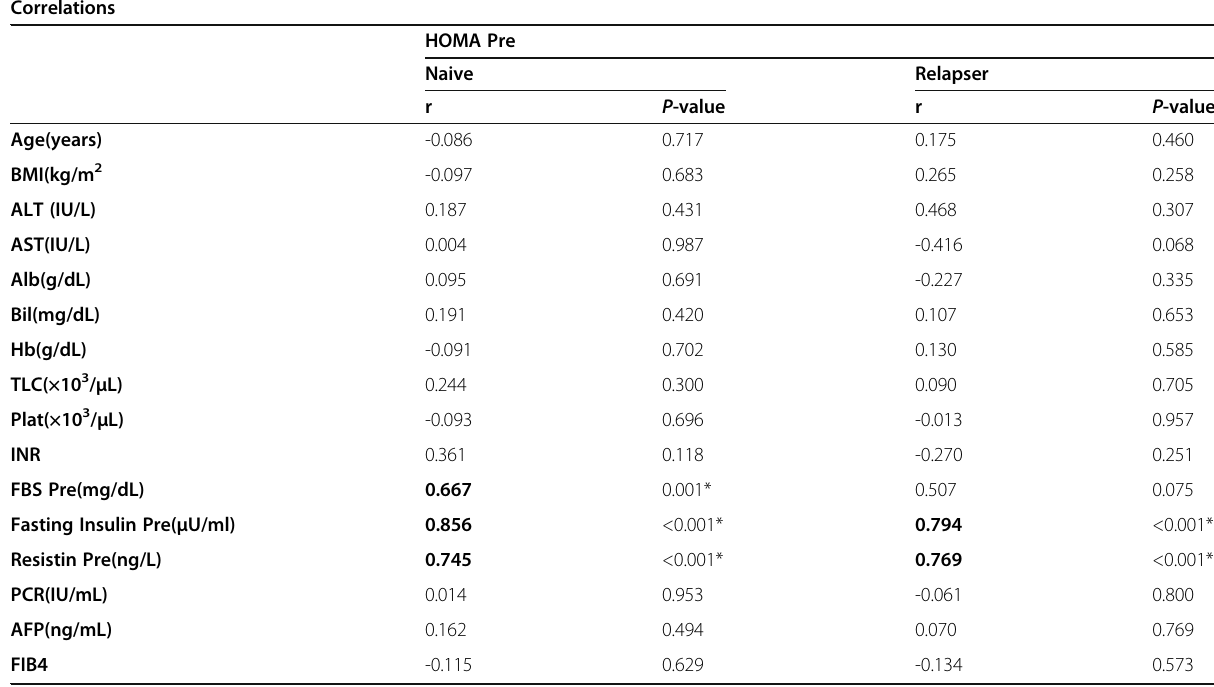
Table 5 Correlation between Pre-treatment HOMA -IR with demographic and laboratory data in both Groups of patients Correlations